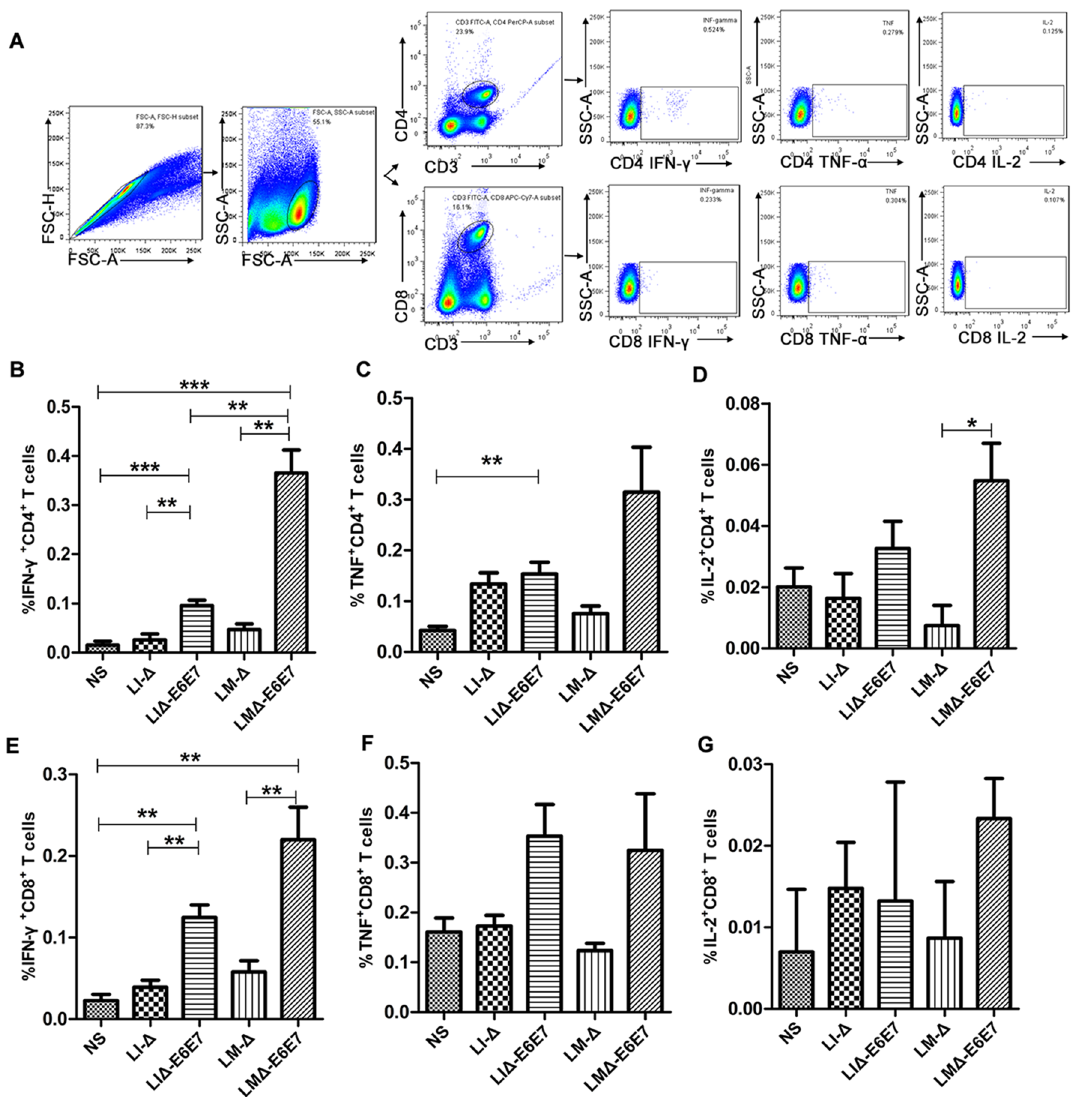
Figure 4. Specific cellular responses induced by the recombinant strains. C57BL/6J mice (9 mice/group) were intravenously immunized with the LMΔ-E6E7, LIΔ-E6E7, LMΔ- LacZ and LIΔ -LacZ at the dose of 0.1 × LD 50 or NS as placebo, respectively. Splenocytes were prepared on day 9 after first immunization of vaccines, stimulated with the mixed peptides and detected the percentages of IFN-γ, TNF-α or IL-2 producing CD4 + T and CD8 + T cells by flow cytometry. ( A ) The gating strategy for flow cytometry. ( B – G ) Data on the percentages of IFN-γ, TNF-α or IL-2 producing CD4 + T and CD8 + T cells induced by different recombinant strains with significant differences indicated. The data presented (mean ± SEM) were from one independent experiment. All the experiments were performed in triplicate. *** P < 0.001, ** P < 0.01, * P <